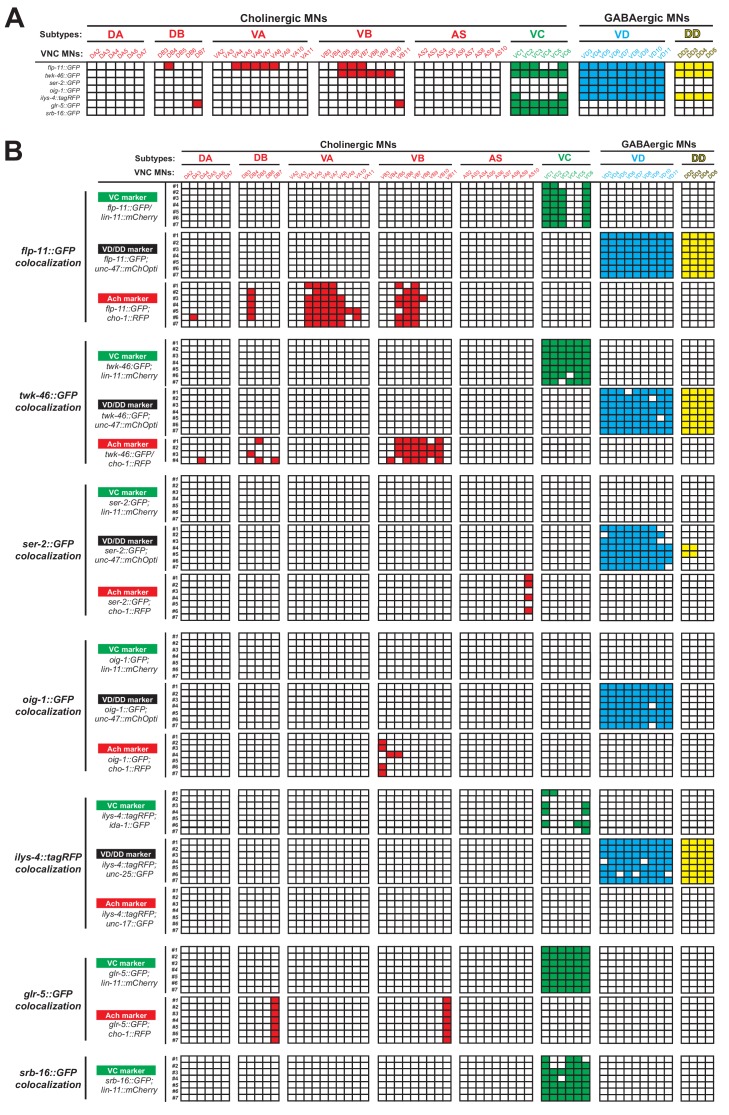
Detailed characterization of the expression pattern of VC and VD terminal identity markers.(A) An expression map of VC and VD terminal identity genes with single-cell resolution at larval stage 4 (L4). Each column represents an individual motor neuron (MN) in the ventral nerve cord (VNC) of a hermaphrodite worm. MN subtypes are color-coded. This table represents a summary of the co-localization analysis described in panel B. Apart from the seven genes listed, we also examined five additional terminal identity genes (bra-1, dhc-1, rgs-4, vhp-1, vps-25) but found no evidence for expression in VD or VC neurons. (B) Co-localization analysis of VD and VC terminal identity genes. Each column represents an individual MN in the VNC of a hermaphrodite worm. Each row represents a randomly-selected worm co-expressing the respective VD or VC marker and one of the known identity markers: unc-47::mChOpti or unc-25::gfp for GABAergic (VD and DD) MN identity, cho-1::rfp or unc-17::gfp for cholinergic MN identity and lin-11::mCherry or ida-1::gfp for VC MN identity. A color-filled lattice indicates co-expression of the known identity marker and the selected marker in the individual MN.